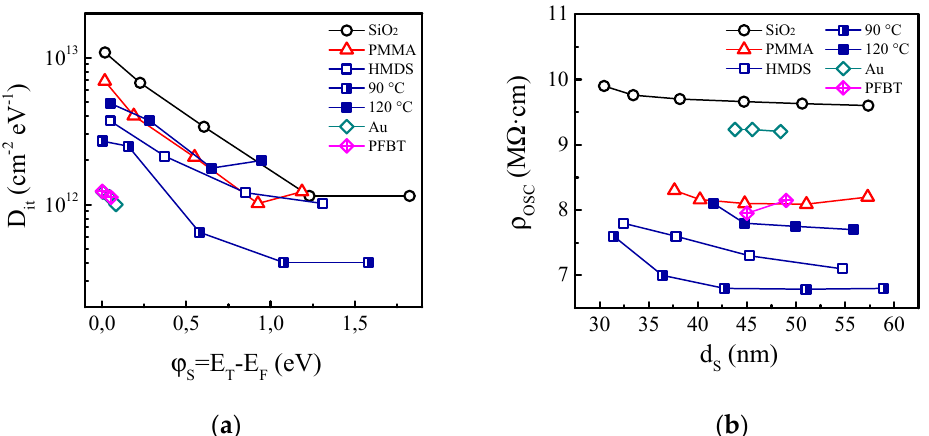
Figure 9. ( a ) Interface density of states as a function of surface potential and ( b ) average resistivity of the OSC bulk of thickness d s next to source contact. For BG devices, open, half-solid, and solid symbols denote the semiconductor deposition at RT, 90 °C, and 120 °C, respectively, while the different colors indicate the various insulator interfaces (SiO 2 , PMMA, and HMDS). TG devices are denoted by diamond symbols, of which the cross-centered one indicates the Au contact functionalization (PFBT).